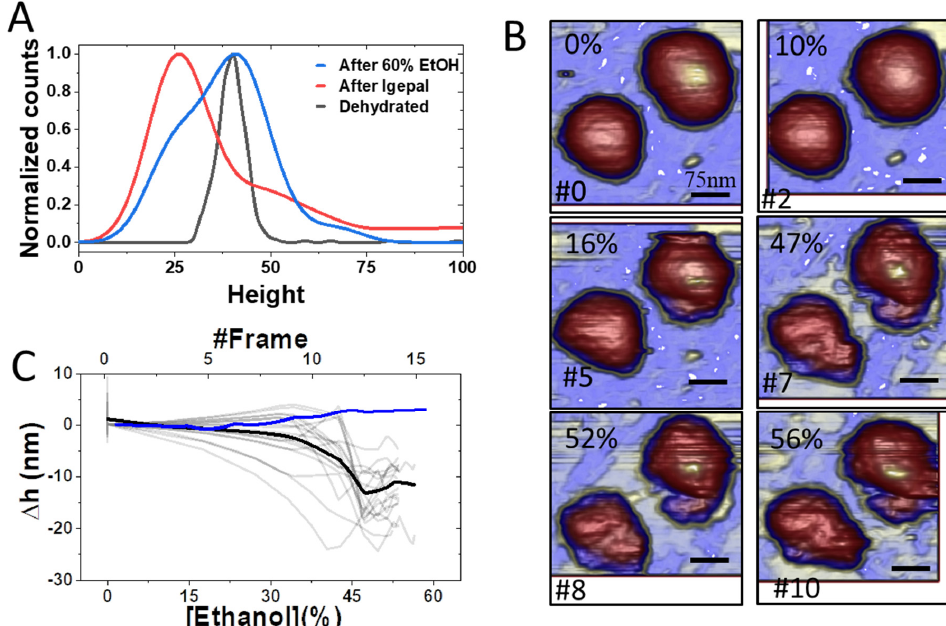
Figure 5. Effect of ethanol gradient on TGEV virions ( A ). Comparison of virion height distribution after treatment with 60% ethanol, 0.2% IGEPAL or dehydration ( B ). Consecutive imaging of TGEV virions during the increase in ethanol concentration. The concentration of ethanol is shown in the upper left corner and frame is shown in the lower left corner (video S6) ( C ). Track of the height loss during the ethanol time course. Experimental data is shown in grey, the average curve of 23 observations is shown in black and the average of 5 viruses without ethanol is shown in blue (video S5).